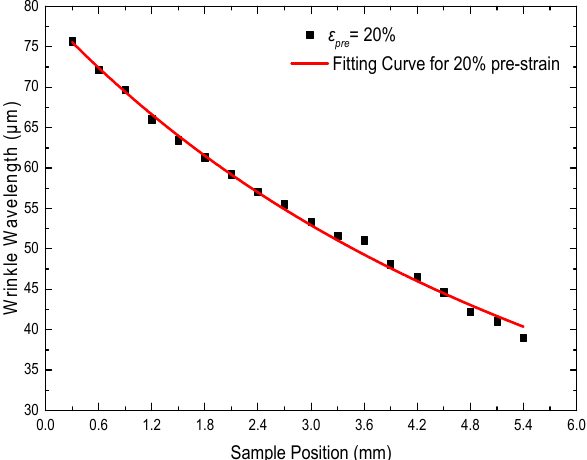
Figure 3. Wrinkle wavelength λ as a function of sample position at 20% pre-strain. The red curve represents the fit according to the relation between λ and the distance d using Equations (3) and (4).